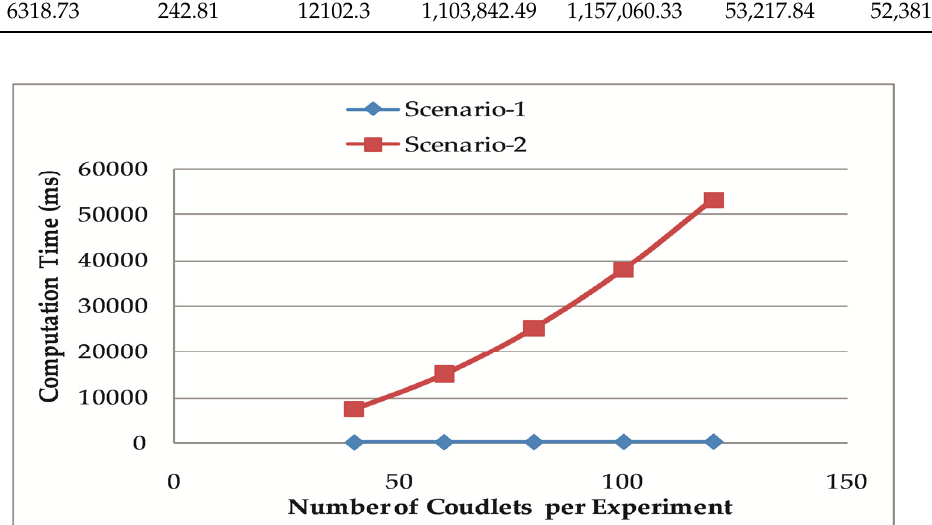
Figure 6. Computation time versus number of cloudlets.